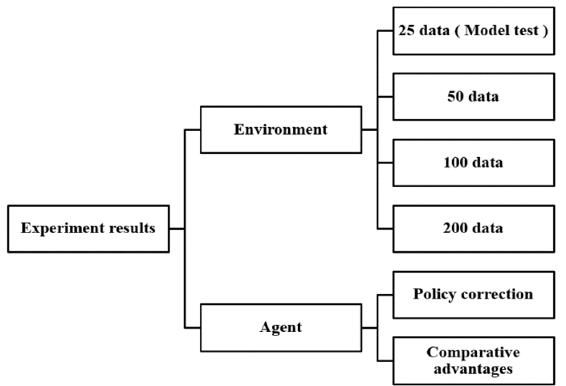
Figure 10. Overview of experiments with various quantities of positioning error data and different agent behaviors and